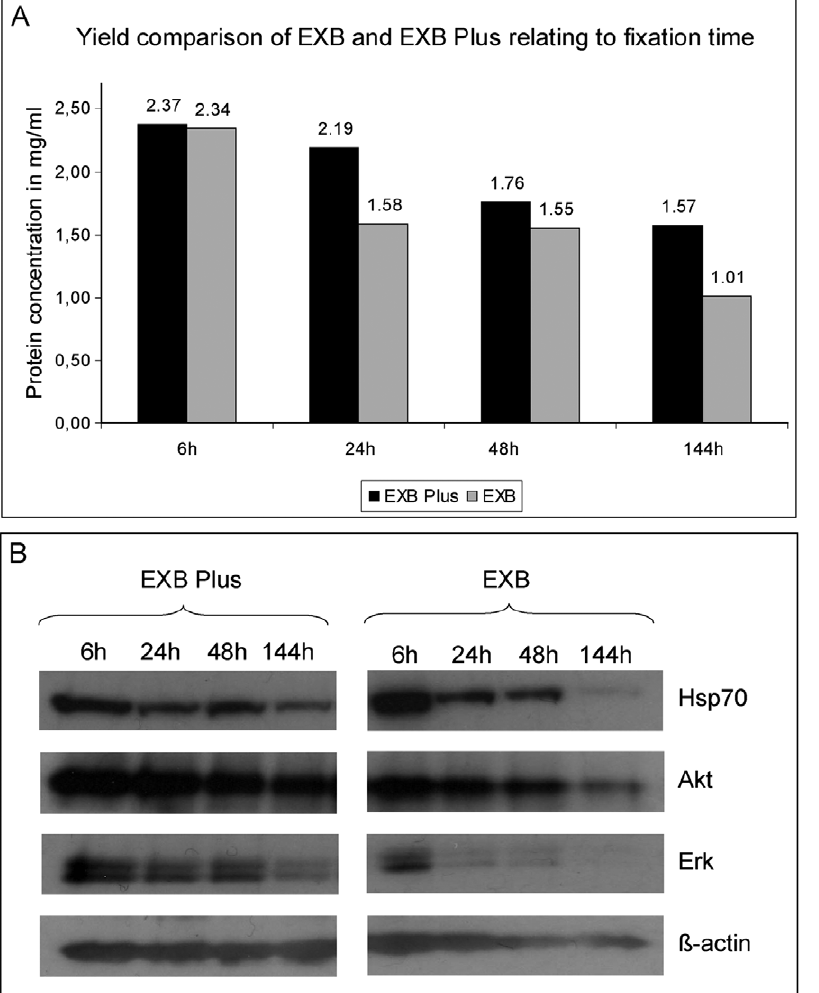
Figure 1. Comparison of proteins extracted from five different tissues with EXB and EXB Plus, respectively. A Using EXB Plus considerably higher lysate concentrations could be obtained for each of the tissue types. B Western blot analysis of E-Cadherin, Erk and b -actin in five different tissues. For both buffers we obtained clear bands in the western blot, confirming that we were able to extract non-degraded, full-length, and immunoreactive proteins. In addition it is distinguishable that the extracted protein amount from all five tissues of all three analysed proteins is higher using EXB Plus.